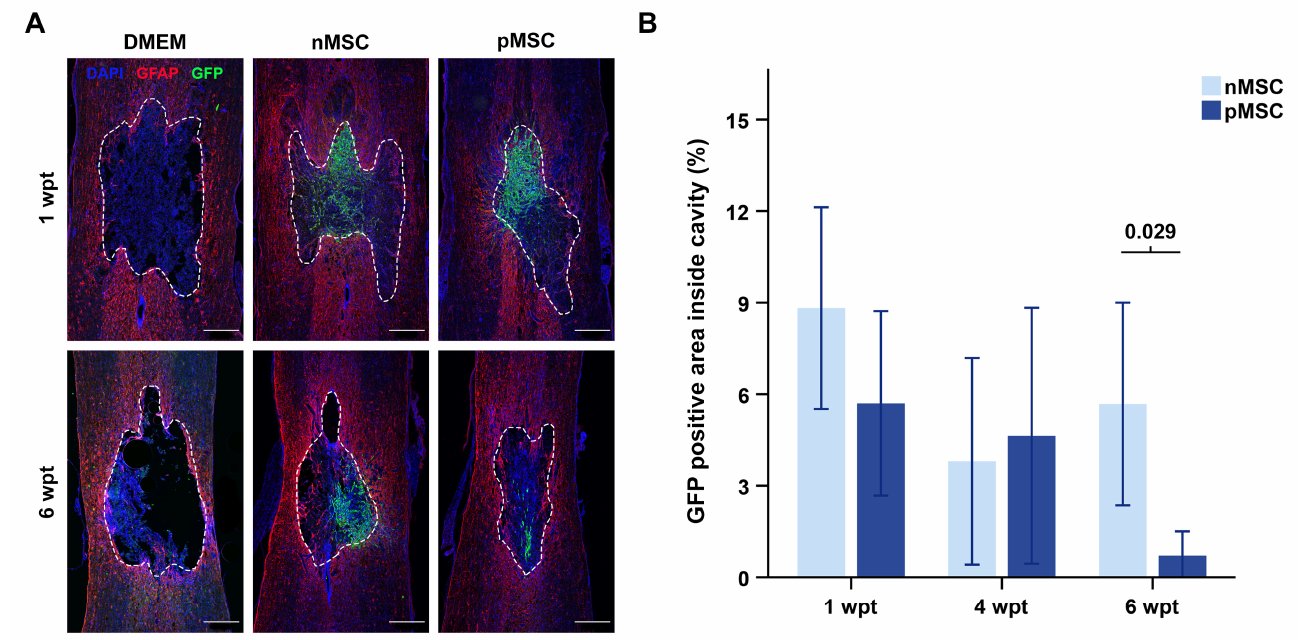
Figure 2. Inflammatory priming decreases long-term survival of MSC in the contused spinal cord. ( A ) Photomicrographs representing examples of injured spinal cords at 1 and 6 wpt for the vehicle injected animals (DMEM), the nMSC transplanted animals, and the pMSC transplanted animals. The immunostaining marks astrocytes in red (GFAP), transplants in green (GFP), and cell nuclei in blue (DAPI). The dashed lines represent the manually selected regions of interest (ROIs) to designate the injury cavity. Any green fluorescence detected on the DMEM images is a product of auto fluorescence, since those